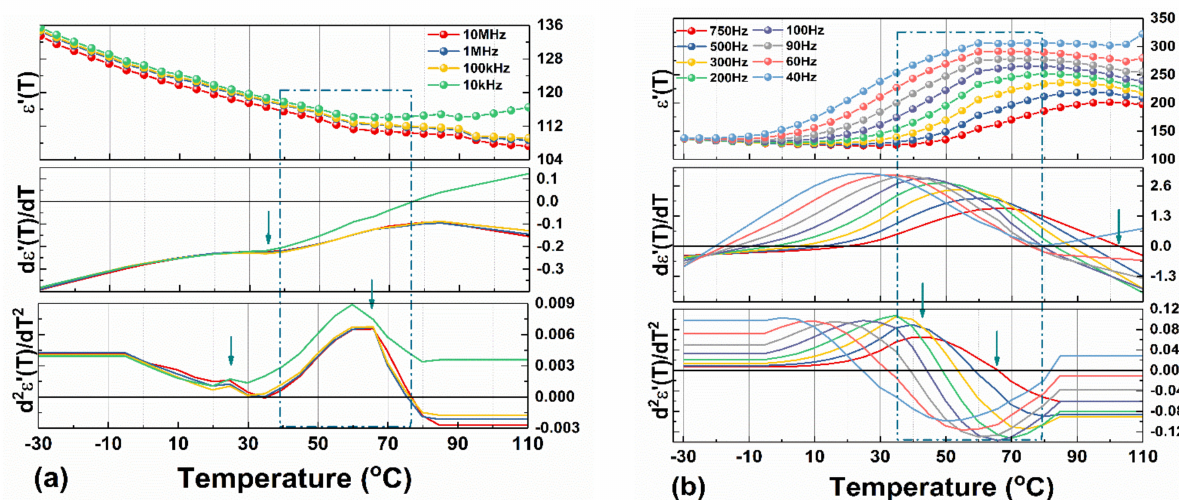
Figure 7. The real part of the dielectric constant measured during heating and the corresponding first- and second-order derivatives with respect to temperature for a few selected frequencies in the ranges: ( a ) 10 kHz ÷ 10 MHz; ( b ) 40 Hz ÷ 750